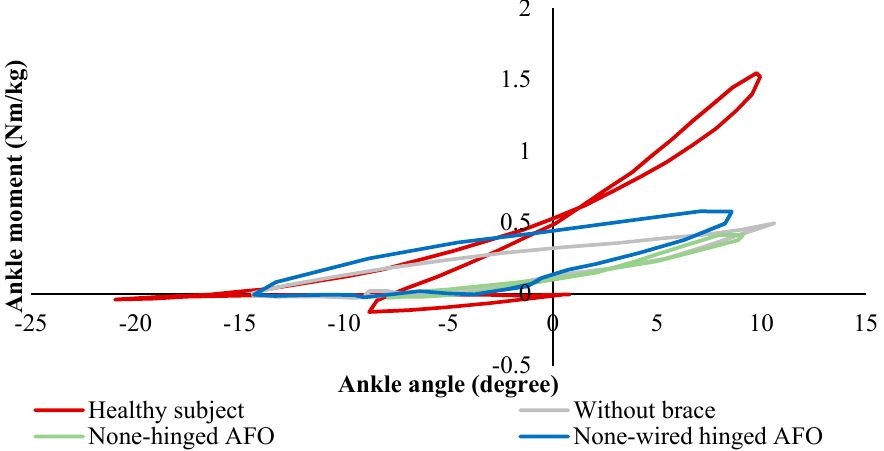
Figure 20. Ankle stiffness variation over the gait cycle for healthy subject and the drop foot patient with and without AFO [49].